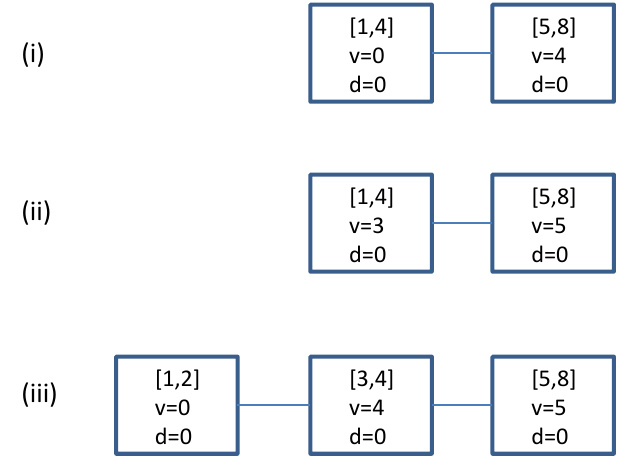
Figure 1. Suppose that λ = 4 . (i) shows the queue Q a ( a, 1) , ( a, 2) , ( a, 3) , ( a, 8) ; (ii) is the resulting queue after the updates for these